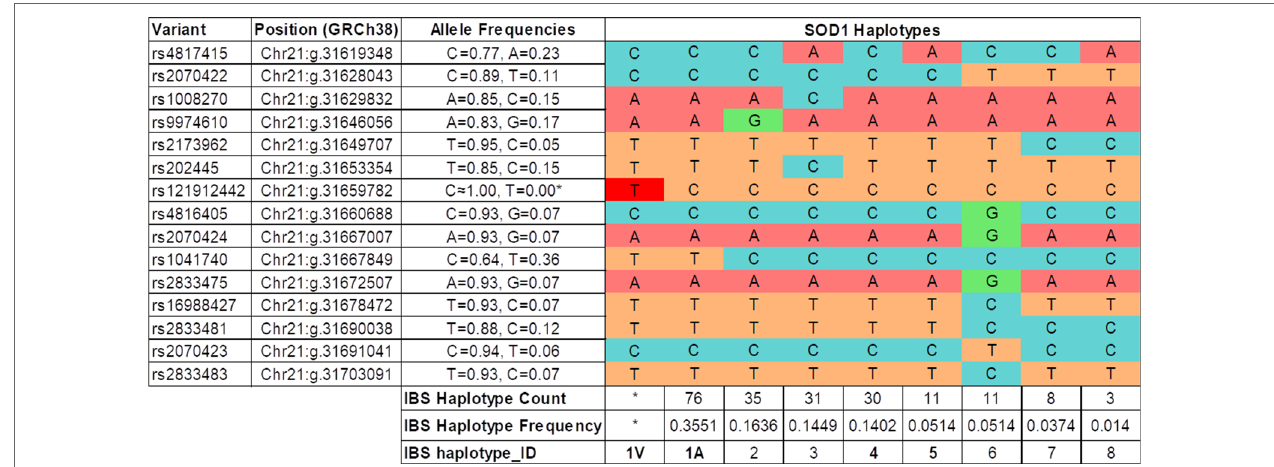
FIGURe 2 | Haplotypes inferred in the IBS population (1K Genomes Project). The IBS haplotype_ID codification is based on the frequency of the haplotype in the IBS population, and in the case of the most frequent (IBS haplotype_ID = 1) the presence of the SOD1 p.A5V protein mutation (1V). (*) The haplotype 1V and allele rs121912442T are only present in the Spanish ALS patients with the SOD1 p.A5V